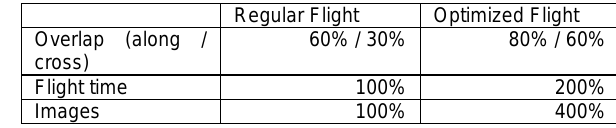
Table 1: Increase of cost due to optimized flight